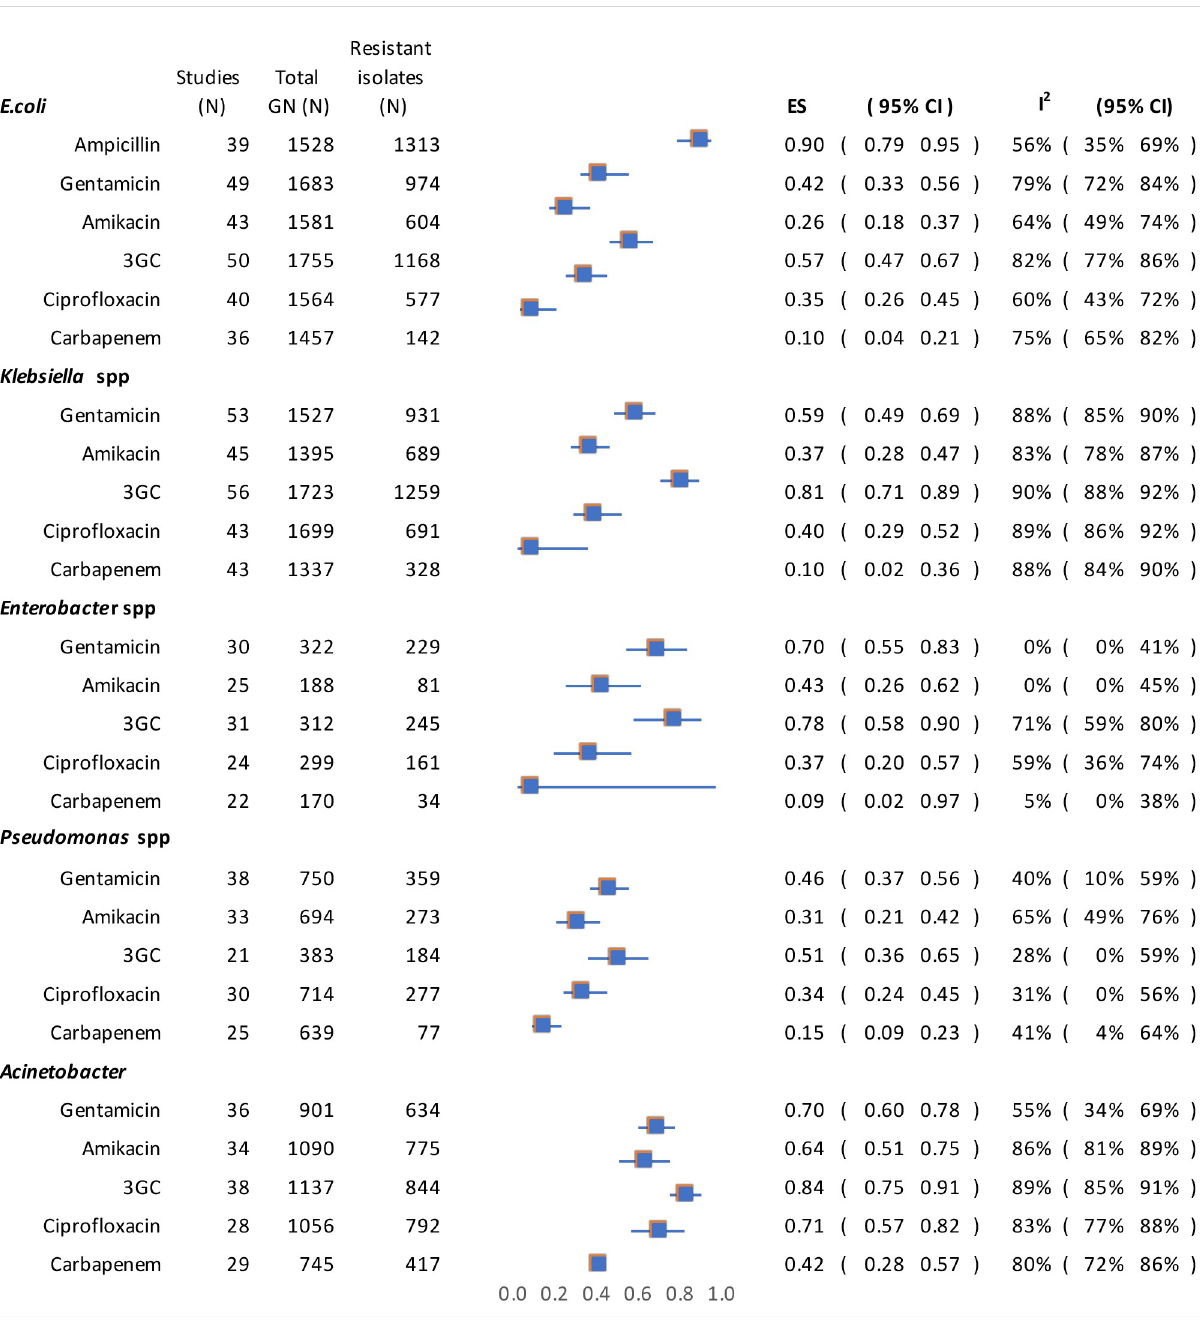
PLOS Medicine| https://doi.org/10.1371/journal.pmed.1003787 September 28,